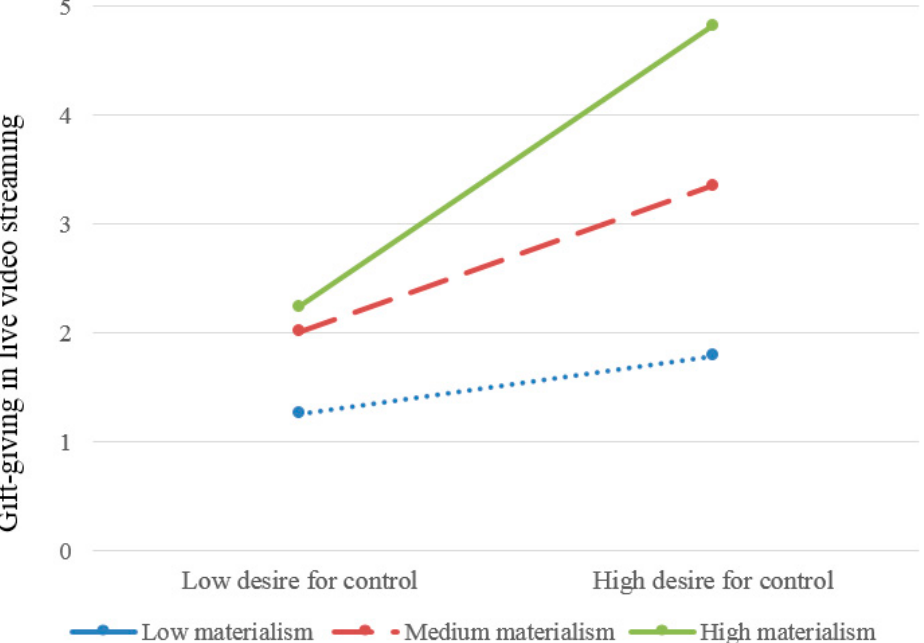
Figure 1. The association between desire for control and gift-giving for different level of material-